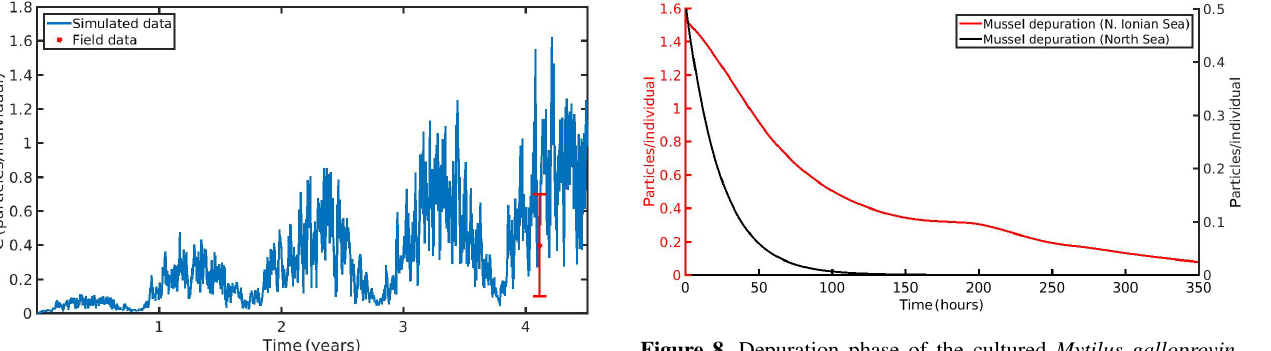
Figure 8. Depuration phase of the cultured Mytilus galloprovin- cialis (red line) and wild Mytilus edulis (black line) using zero en- vironmental concentration of microplastics ( C env = 0) after 1 and 4 years of simulation time in the northern Ionian Sea and North Sea